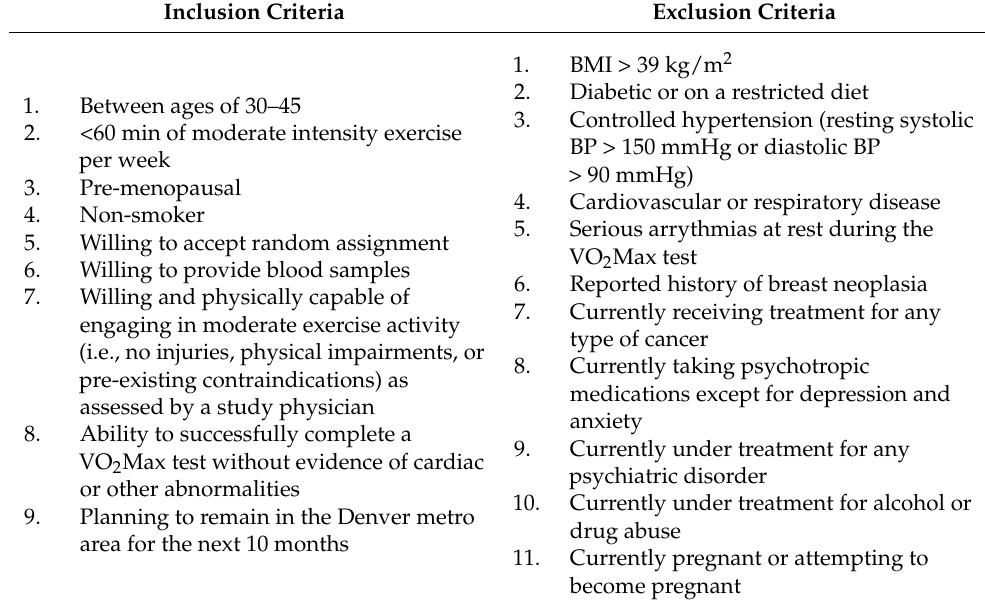
Table 1. Study eligibility criteria.